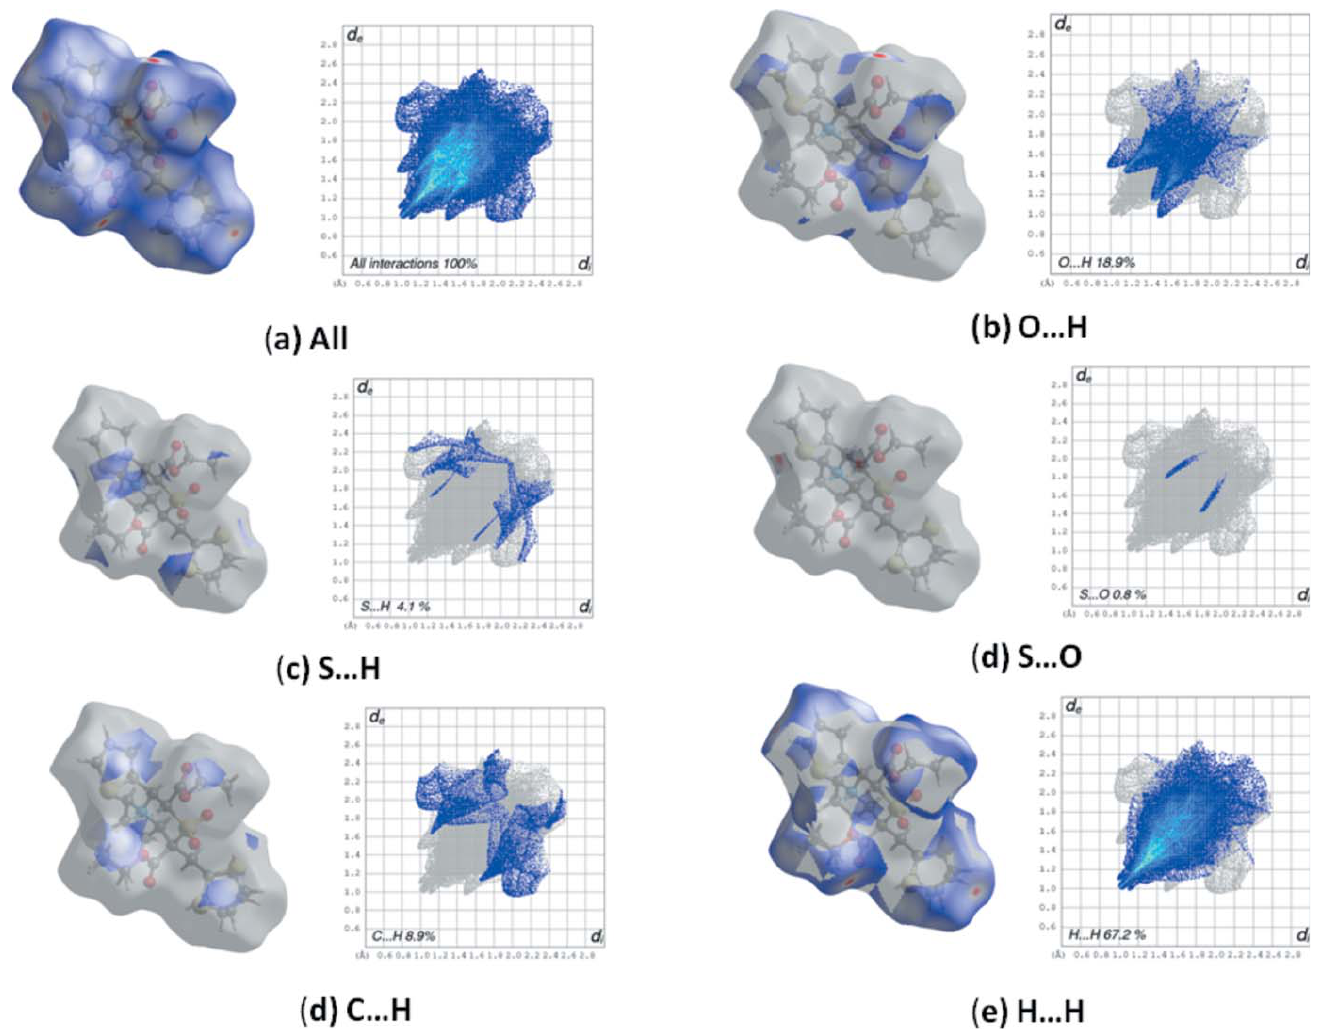
Figure 5 Hirshfeld surface mapped over d norm and decomposed fingerprint plots for the dominant